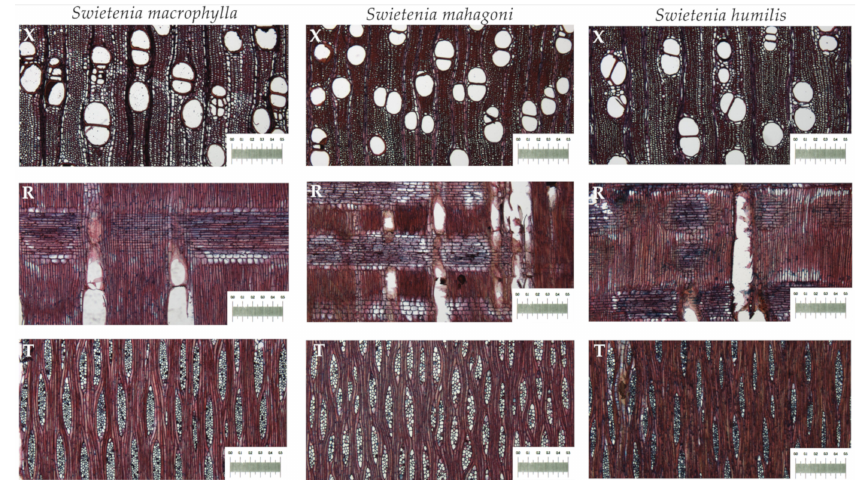
Figure 1. The three planes of sections of S. macrophylla , S. mahagoni , and S. humilis, showing the similarity of the three species with regard to wood anatomical features. Legend: X, cross section; R, radial section; T, tangential section.